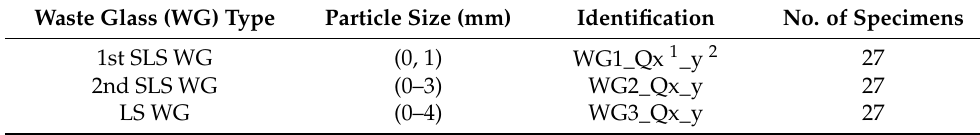
Table 1. Identification of WG